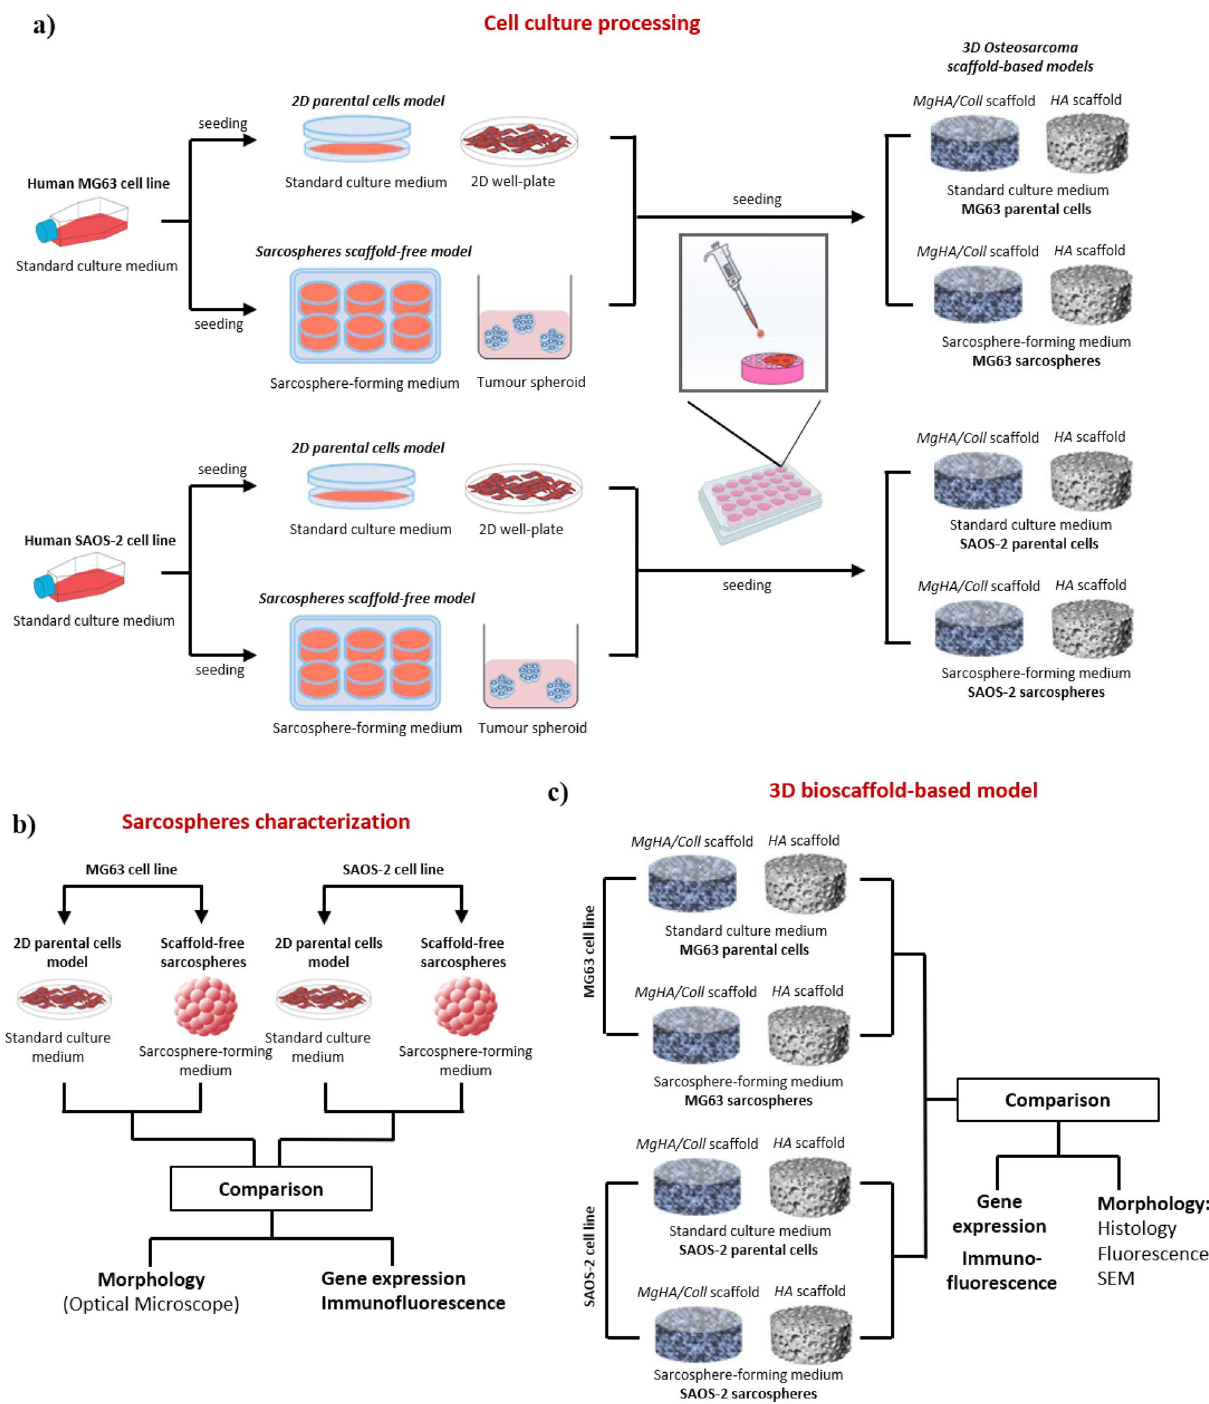
Figure 8. Graphical representation of the experimental plan. ( a ) Cell culture processing of tumour parental cells and sarcospheres of both cell lines for the development of the 3D scaffold-based models of osteosarcoma. ( b ) Sarcospheres characterization of both cell lines compared to 2D parental cells. ( c ) Experimental plan and characterization of the two phenotypes (parental and sarcospheres) in the 3D osteosarcoma models. Scaffold- free sarcospheres were used as a